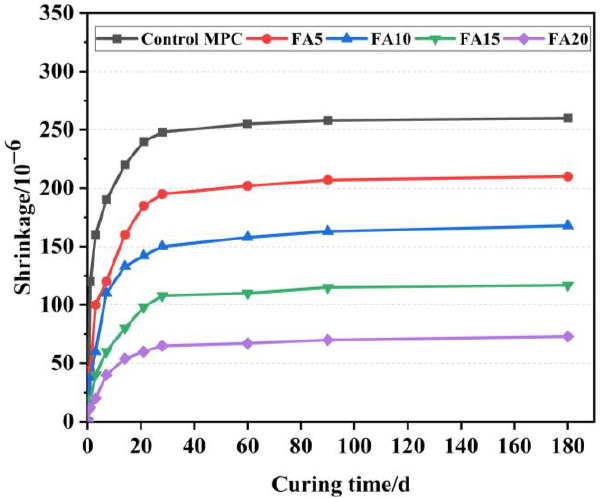
Figure 18. Effect of FA on MPC drying shrinkage deformation.